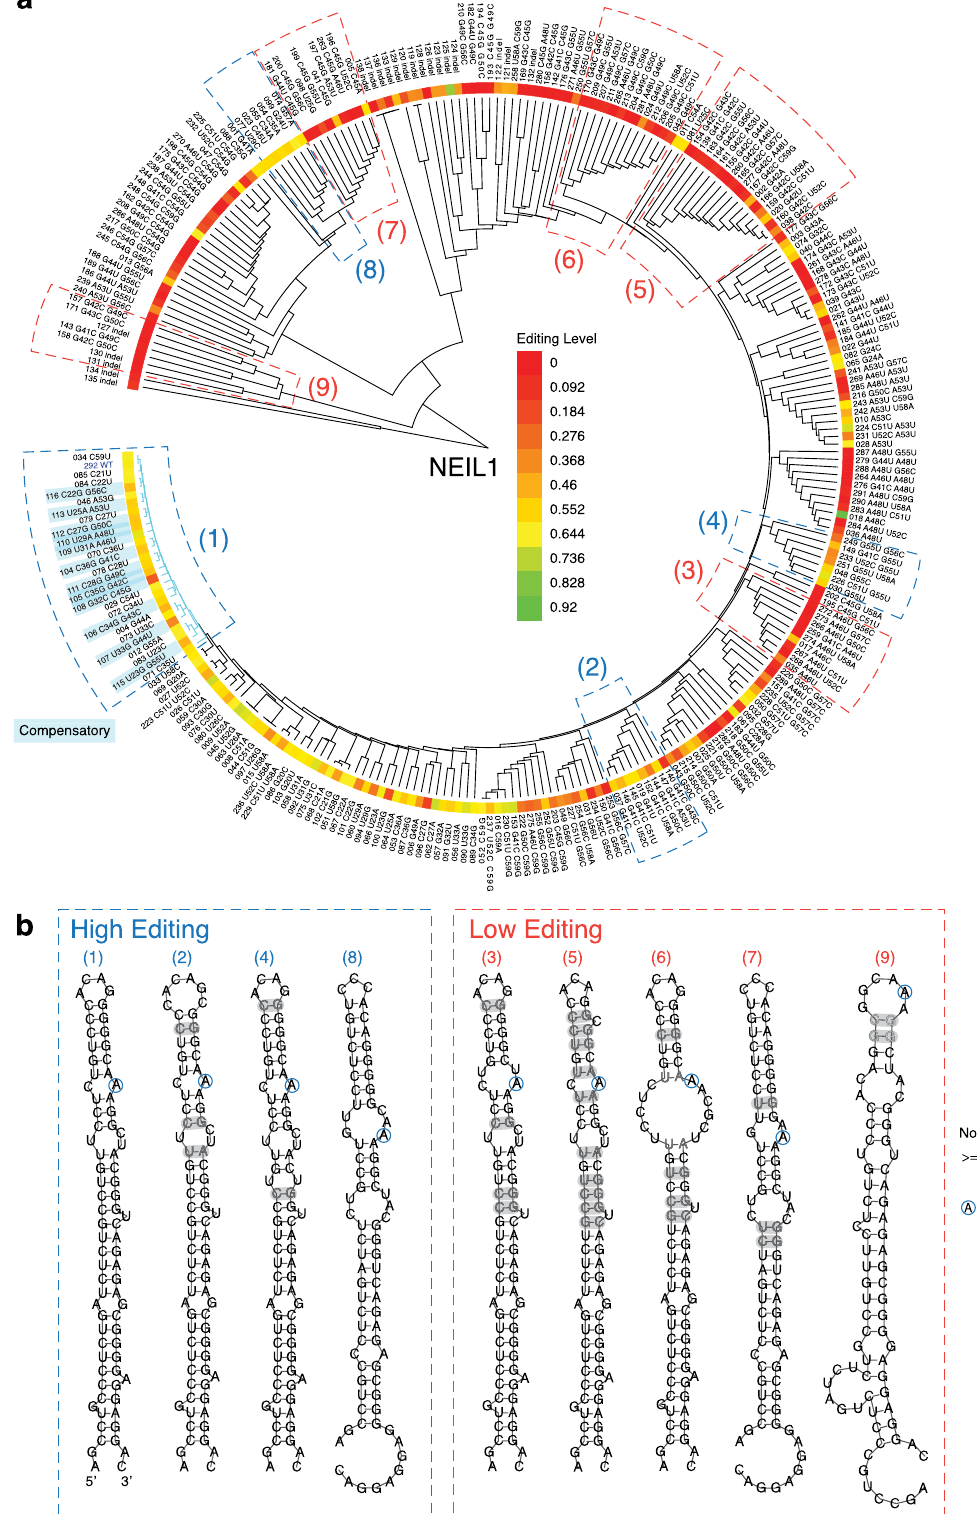
Fig. 6 NEIL1 RNA clustering reveals ef fi ciently edited alternative structures. a NEIL1 variants are clustered by RNAclust from the multiple sequence – structure alignment generated by mlocarna. The editing level of each variant are shown according to the heatmap scale. The sequence and structure corresponding to each RNA ID are listed in Supplementary Data 2. b Consensus secondary structure of selected clusters from a and grouped by editing levels. The gray box ( “ not base-paired ” ) indicates that there is at least one variant within the cluster that has a different MFE structure at this position (see examples in Supplementary Fig.